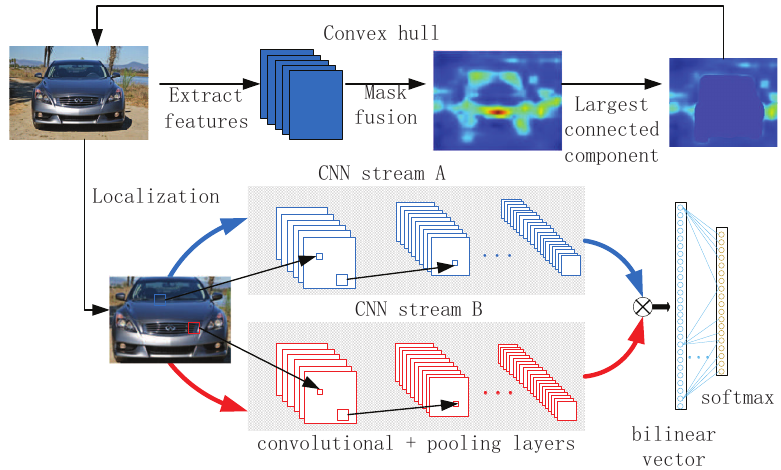
Figure 3. Schematic diagram of weakly supervised